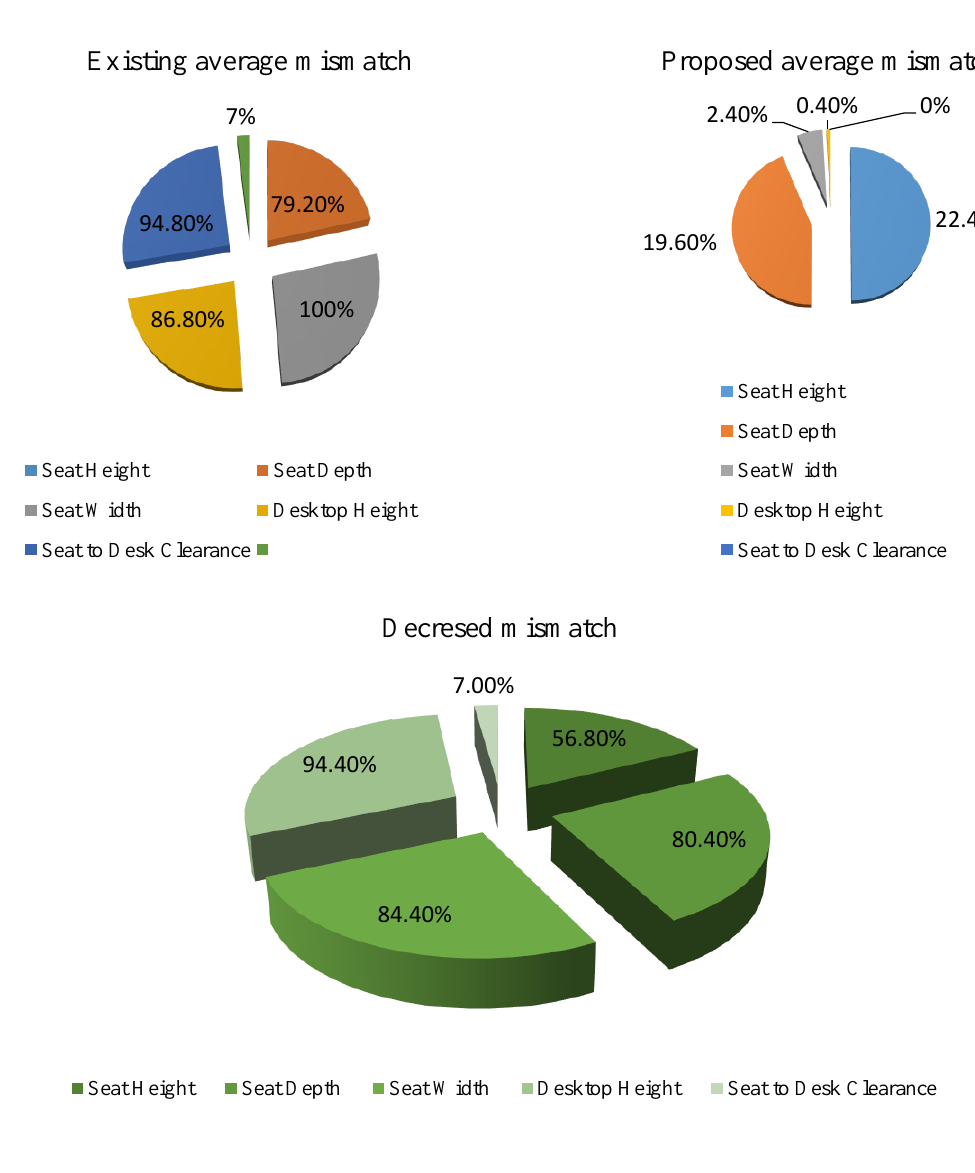
Figure 4. Comparison between existing and proposed dimensions (6-10